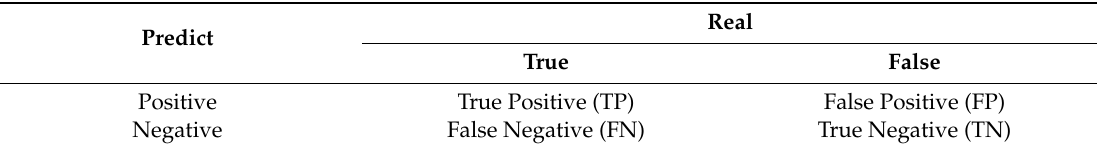
Table 3. Definition of Confusion